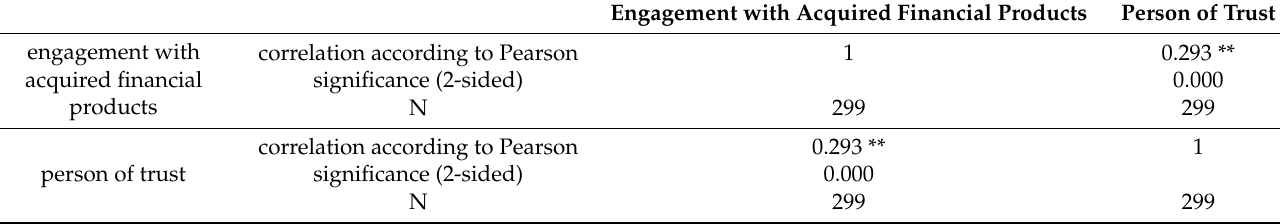
Table 6. Correlations H4.